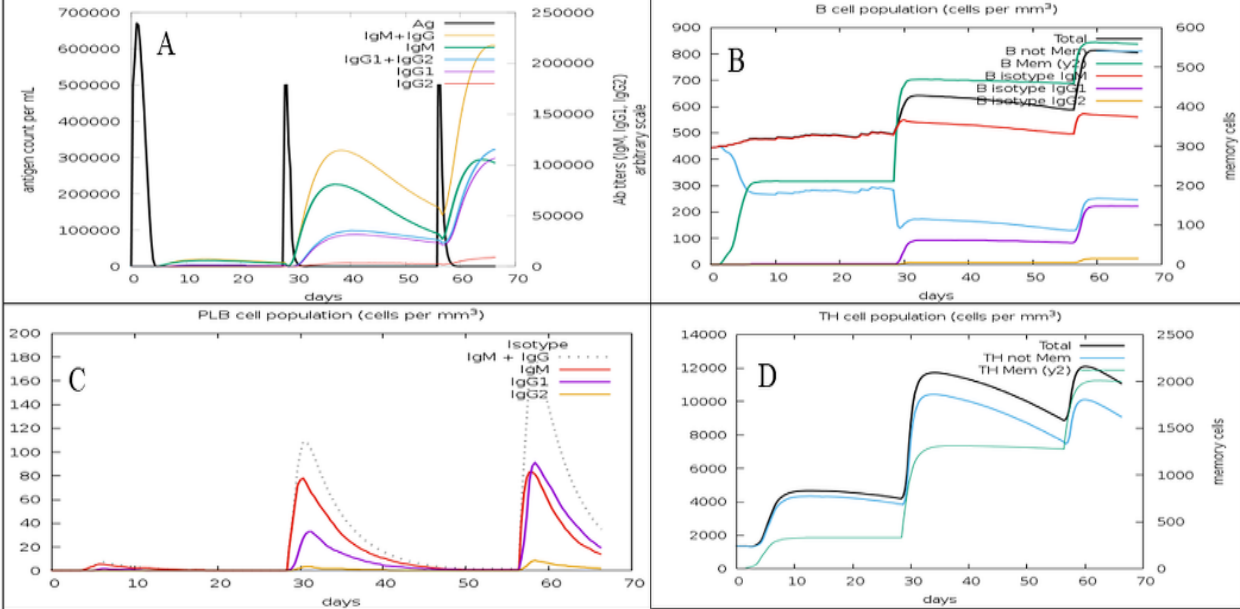
Figure 5. Immune profile of the fungal MEV candidate showing ( A ) antigen count and antibody titer with Ig subclass; ( B ) B-cell population; ( C ) plasma B-cell population; ( D ) T h population per state; ( E ) cytokines and interleukins population. 4. Discussion Although C. dubliniensis is less virulent than C. albicans , the public health concern of C. dubliniensis cannot be overlooked due to its increased resistance to antifungal drugs and also its correlation with several health complications such as meningitis, endocarditis, spondylodiscitis, and oral and respiratory candidiasis, in immunocompromised patients [1,6,11]. Thus, it is urgently required to seek novel and effective drugs, immunotherapy, and vaccines to prevent and cure C. dubliniensis infections. Plant-derived DNA topoiso- merase inhibitors such as curcumin, etoposide, and camptothecin have shown strong an- tifungal activity against C. dubliniensis [61]. Similarly, a potential immunotherapy that used complement receptor 3-related protein (CR3-RP) antibody has shown anti-biofilm activity against C. dubliniensis [62]. However, a vaccine targeting C. dubliniensis has not been reported yet. Thus, we conducted a study using an in silico approach towards find- ing a novel multi-epitope vaccine candidate against C. dubliniensis . Recently, the usage of immunoinformatics for developing vaccine candidates has significantly increased, since this in silico-based approach is time- and cost-saving in formulating novel vaccine candi- dates [41–45,63]. Interestingly, similar in silico strategies have been used to design vaccine candidates against other Candida species including C. albicans , C. auris, and C. tropicalis [24,41,64]. Tarang et al. (2020) targeted ALS2, ALS3, ALS4, HYR1, FAV2, HWP1, EAP1, and SAP2 proteins of C. albicans to identify B-cell and T-cell epitopes; they identified 18